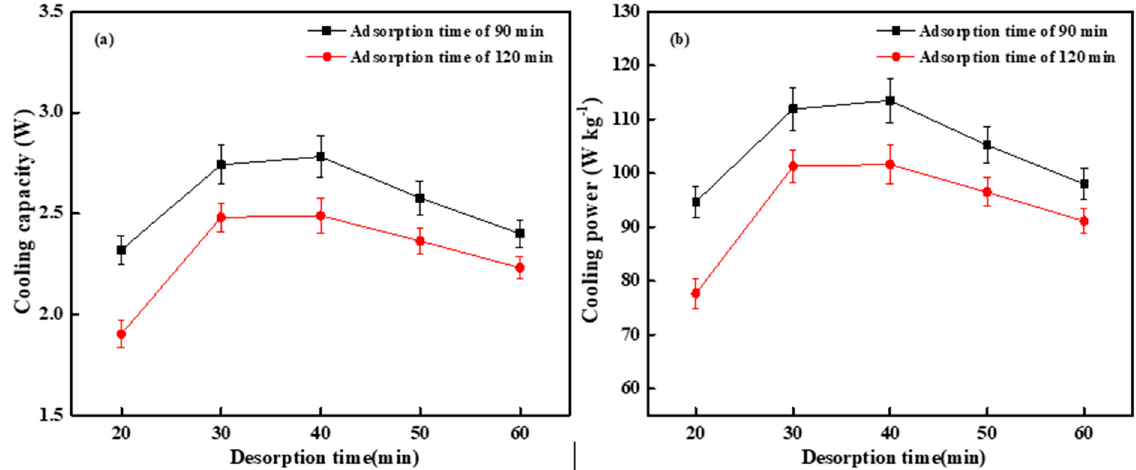
Figure 10. Cooling capacity ( a ) and cooling power ( b ) of an MIL-101/20%FLG-water working pair at different desorption times.